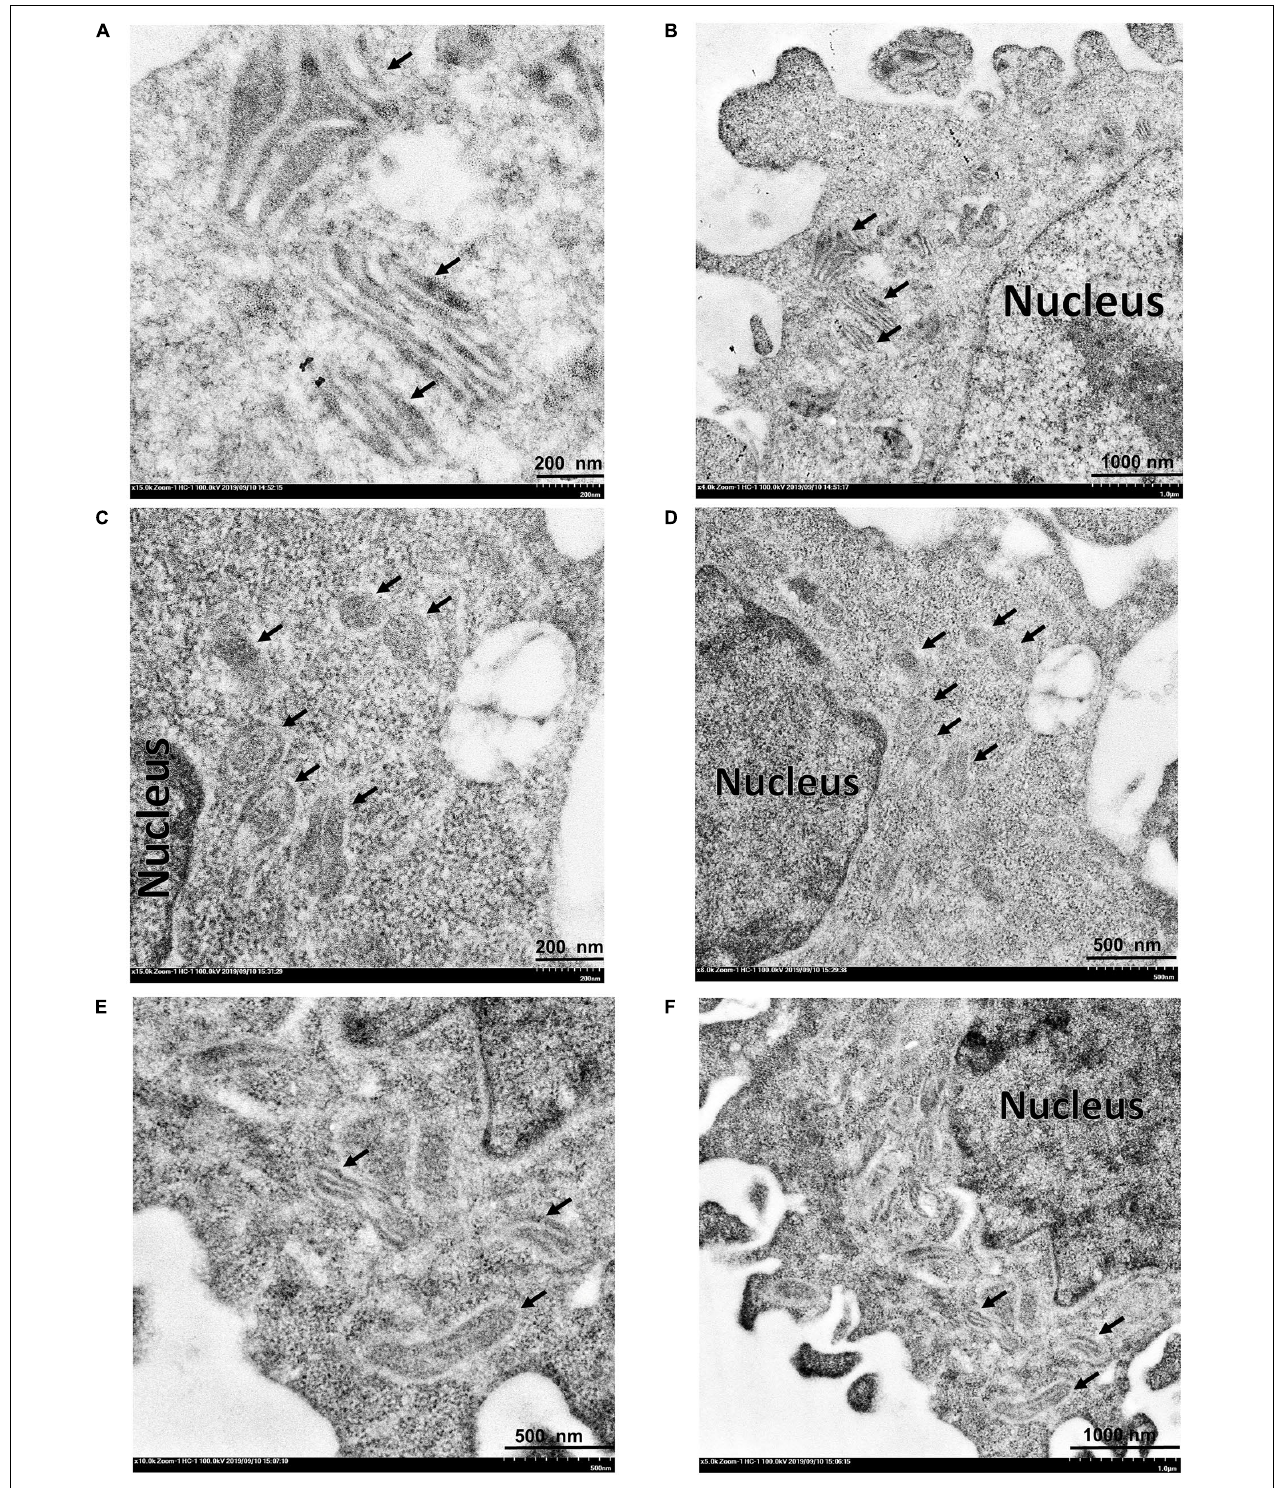
FIGURE 8 | Transmission electron micrographs of mitochondrial ultrastructure. (A,B) normal mitochondria of HeLa cells. (C,D) HeLa cells treated with 3O-C12-HSL (50 µ M). (E,F) HeLa cells treated with a mixture of 50 µ M 3O-C12-HSL and 2 µ M HuscFv-F19. Black arrows indicate mitochondria of the HeLa cells. Mitochondria of the cells exposed to the 3O-C12-HSL were swollen, characterized by a size increment with decreased electron density of the crista-free matrix.